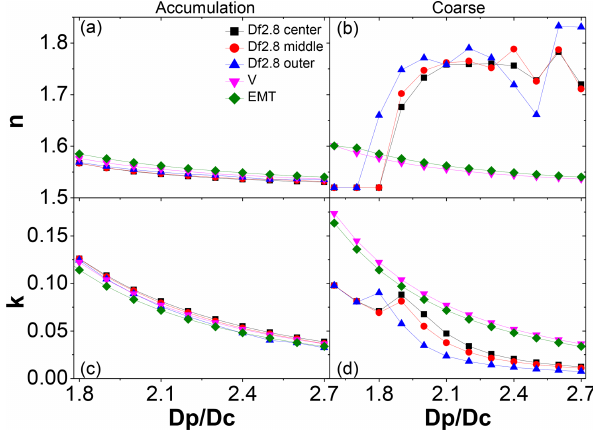
Figure 4. The real ( a and b ) and imaginary ( c and d ) parts of retrieved optically effective aerosol complex refractive indices (ACRIs) of black carbon aggregates coated by sulfate (BC fractal dimension of 2.8) as a function of shell / core ratio ( D p /D c ), in accu- mulation ( a and c ) and coarse ( b and d ) modes, respectively. Three BC coating morphologies are considered, i.e., a core shell with BC mass center located at the particle geometric center (black squares) and two off-center core-shell structures including BC aggregates ly- ing in the middle position of a particle radius (red circles) and the outer position close to the spherical boundary (blue up-triangles). The ACRIs based on the popular volume-weighted average method (magenta down-triangles) and Bruggeman effective medium theory (olive diamonds) are